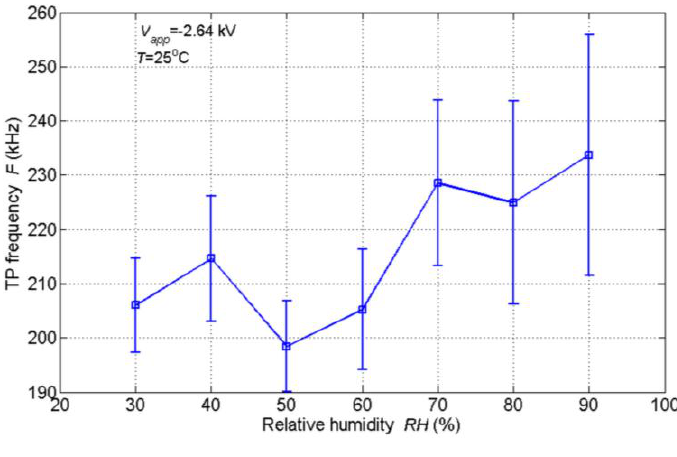
Figure 9. Variation of TP frequency with ambient relative